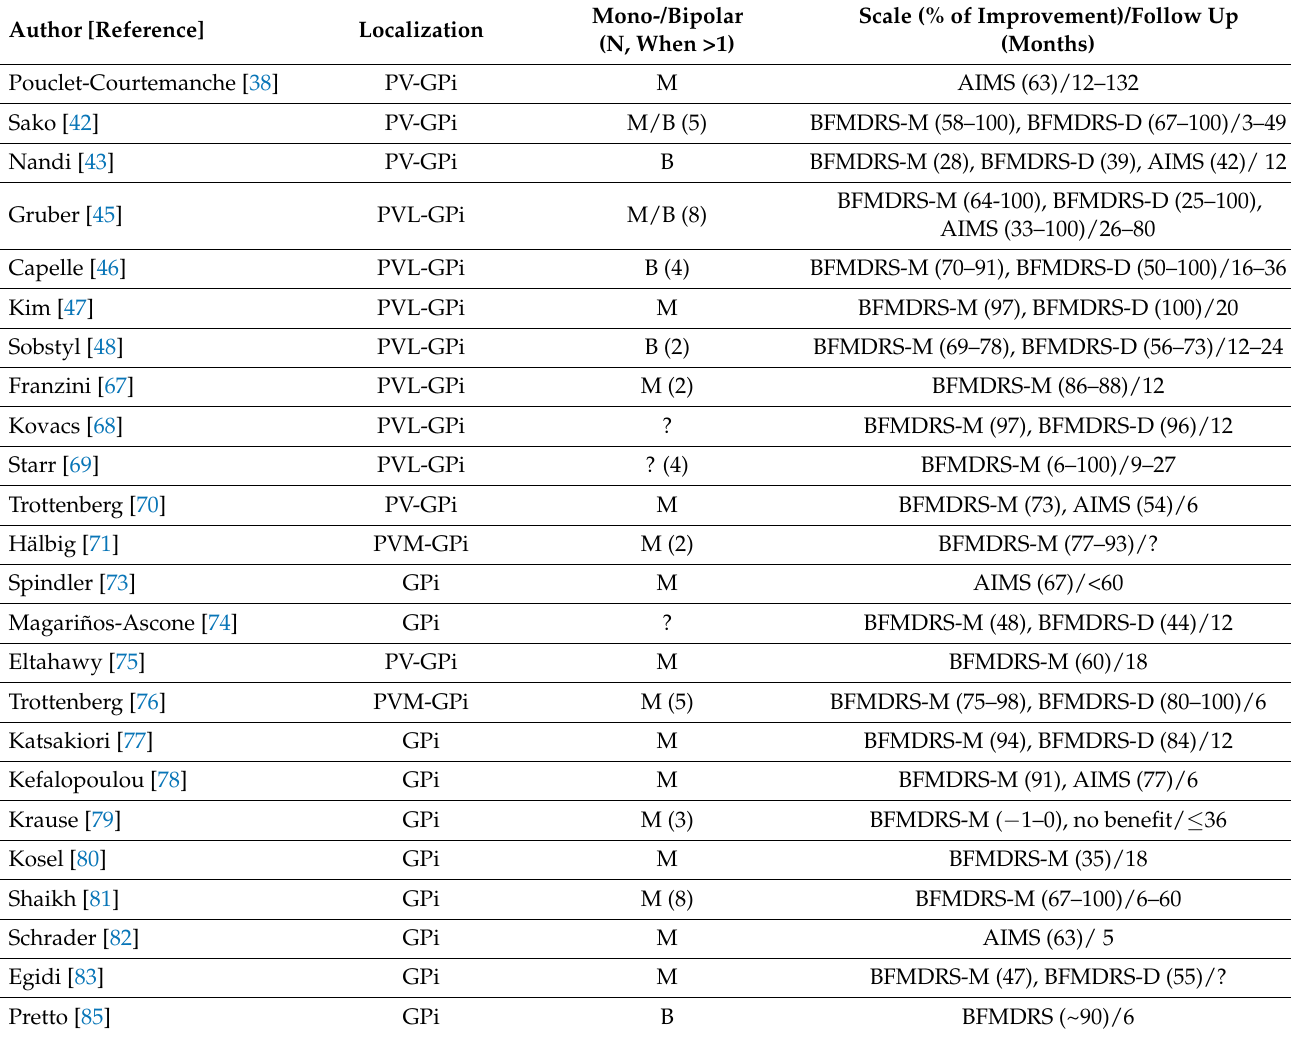
Table 3. Basic parameters and outcomes from GPi DBS